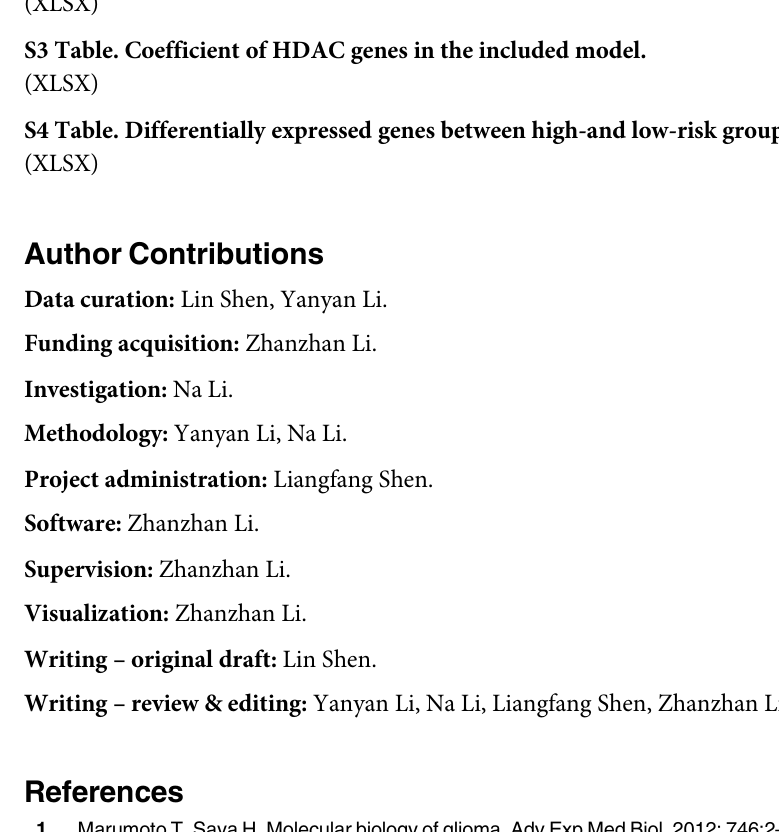
S1 Table. Tripod checklist prediction model development and validation. S2 Table. Clustering of low-grade glioma based on 11 HDAC genes in TCGA. S3 Table. Coefficient of HDAC genes in the included model. S4 Table. Differentially expressed genes between high-and low-risk